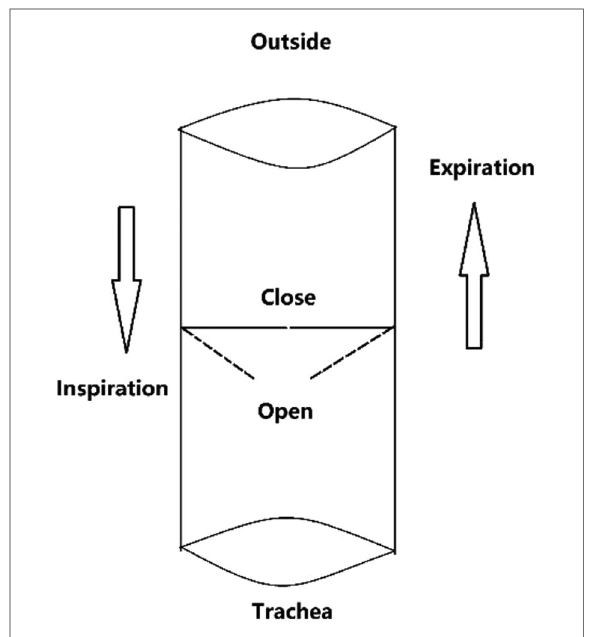
FIGURE 2 Major working principle of speaking valve. When inhaling, the valve opens, air or ventilator gas enters the trachea, and when exhaling, the valve closes, and the air fl ow forms a certain pressure on the catheter and the upper airway, forcing the gas to be discharged from the upper